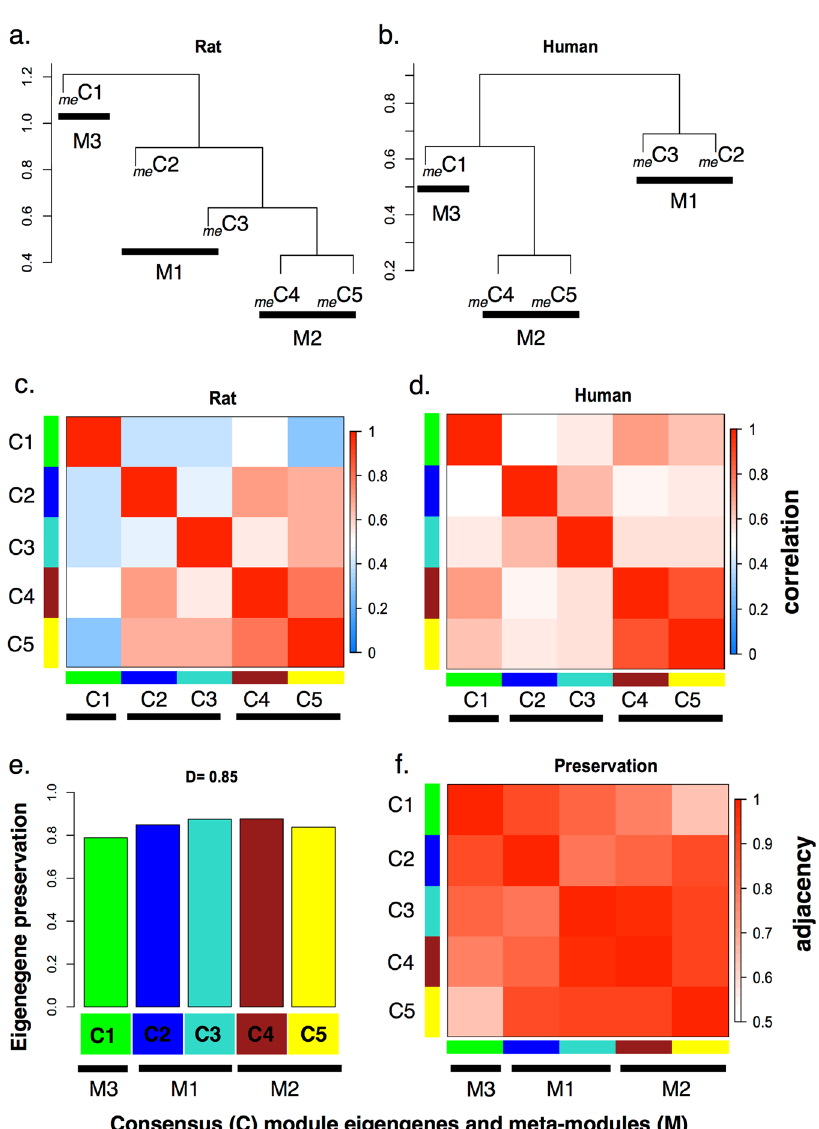
Fig. 4 Differential consensus module eigengene analysis. Differential eigengene network analysis between rat and human consensus module eigengene networks was used to de fi ne the strength of the correlation preservation for all eigengene pairs across the two networks: a , b Clustering dendrograms of consensus module eigengenes ( me ) demonstrates the presence of meta-modules M1 – M3 ( thick horizontal bars ) across both species; the same three major branches are found in both dendrograms . c , d Heatmap plots of eigengene adjacencies for each of the eigengene networks ( c , rat; d , human). Each of the rows and columns indicate an eigengene labeled by the consensus module color. Red indicates high adjacency (positive correlation), while blue indicates the inverse, as depicted by the color legend. e Bar plot of the preservation of the consensus eigengene relationships between the two networks. Each bar represents the eigengene of the associated consensus module; the eigengene preservation measure is given by the height of the bar ( y -axis). The high-density value D (Preserv human,rat ) = 0.85 re fl ects the high overall preservation between the two networks, i.e., correlation preservation is high between all pairs of eigengenes across the two networks. f Adjacency heatmaps for the pair-wise preservation network Preserv human,rat ; high values of Preserv human,rat indicate correlation preservation between pairs of module eigengenes is strong across the two networks. Each consensus module eigengene is represented by the rows and columns , with the level of red saturation indicating adjacency according to the color legend. Overall, the M2 meta-module in both species, derived from C4 and C5 eigengenes, are the most highly correlated. The C3 and C4 modules represented the most highly preserved tease apart this association by using genes associated with aged Although a strong risk factor, ageing alone does not cause OA, rat cartilage for further class prediction analysis. The senescence but promotes OA in conjunction with a number of other risk and age-associated gene BCL6 31 was identi fi ed, but high expres- factors, e.g., obesity, through multifaceted mechanisms that are incompletely understood. 29, 30 Age is a confounding variable in sion was found in both young and healthy cartilage. Ageing chondrocytes do exhibit an associated decline in synthetic this analysis, with the majority of human studies pro fi ling OA capacity (so-called “ chondrocyte senescence ” ) but retain the cartilage from aged patients. In the class prediction analysis from ability to produce pro-in fl ammatory cytokines. 32, 33 Functionally, independent data ostensibly normal cartilage from aged donors is shown to cluster more readily with OA samples. We attempted to this correlates with the M2 meta-module where consensus hubs